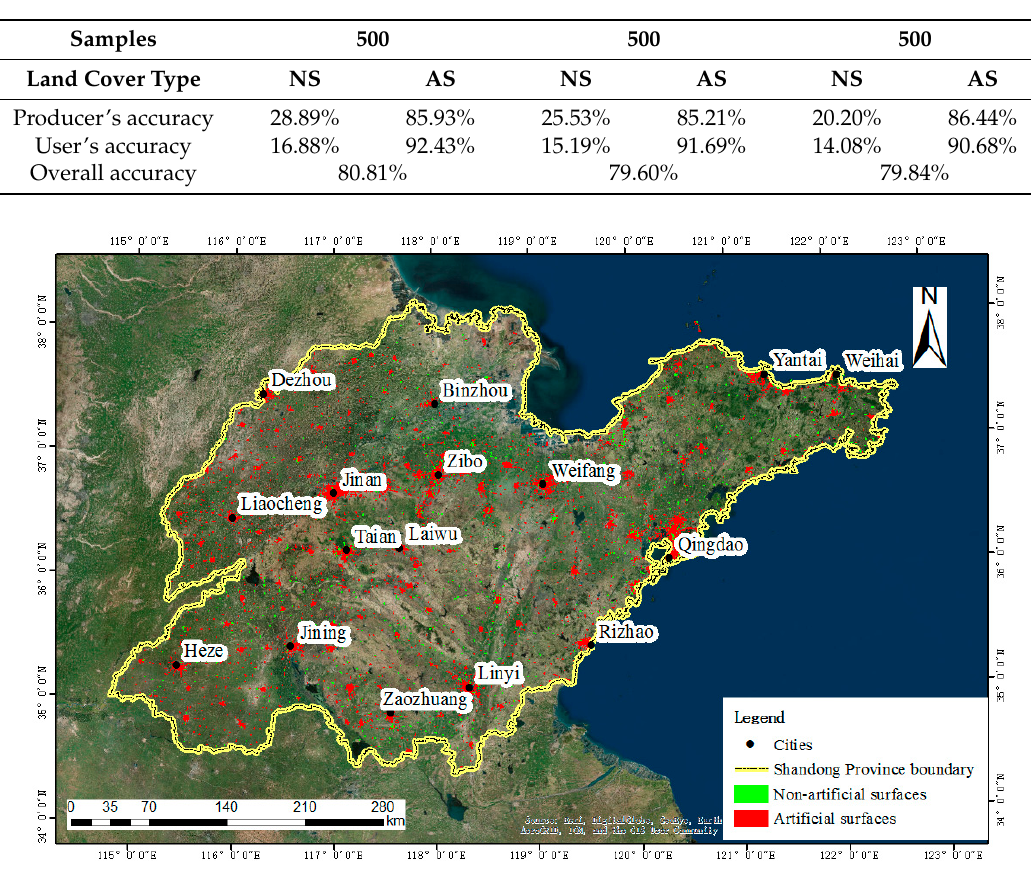
Table 4. Land cover classification accuracy (NS: non-artificial surfaces AS: artificial surfaces).